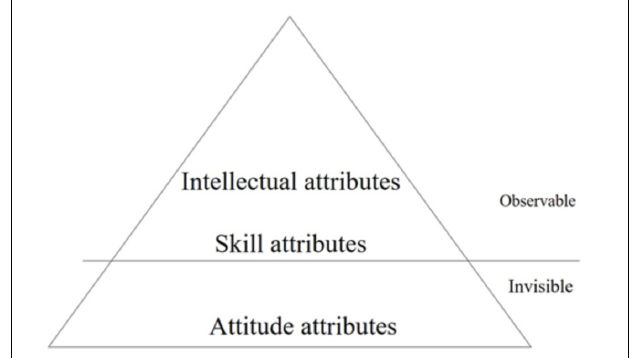
FIGURE 1 | Competency